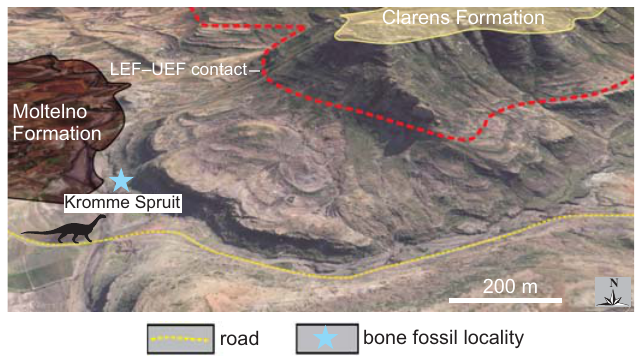
Fig. 4. Stratigraphic relationships at the type locality of Plateosauravus cullingworthi , Kromme Spruit, ~6 km ESE of Sterkspruit, Eastern Cape Province (3027CB). The key stratigraphic contacts have been mapped using the lithological characters of the various stratigraphic units. See Table 1 and text for details. Base image provided by Google